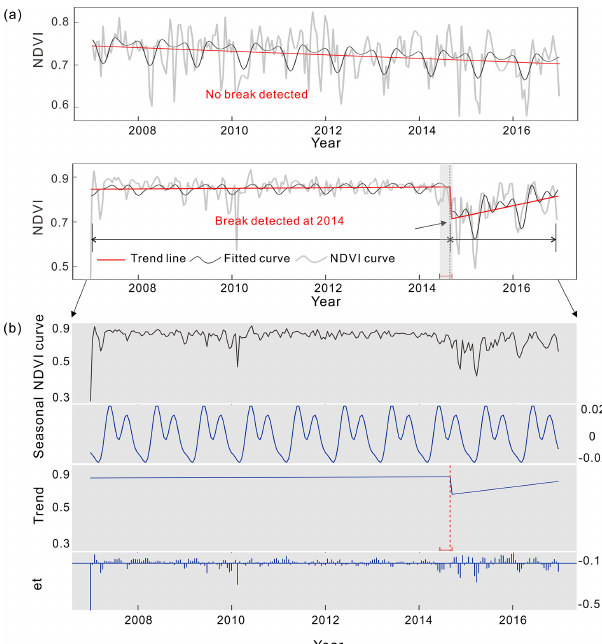
Figure 2. Examples of the break point detection in the MODIS time series using the BFAST algorithm. (a) The two cases present when the algorithm is able to detect the break in the NDVI time se- ries. The NDVI curve is the original 16d composite MODIS NDVI time series. The fitted curve is the pre-processed NDVI after cloud masking and spline interpolation. Trend line shows the fitted trend for each segment after seasonal-trend decomposition using BFAST. (b) The seasonal-trend decomposition of the 16d NDVI time series using BFAST for the second example. The algorithm decomposes the time series into three components: trend, seasonality and resid- uals